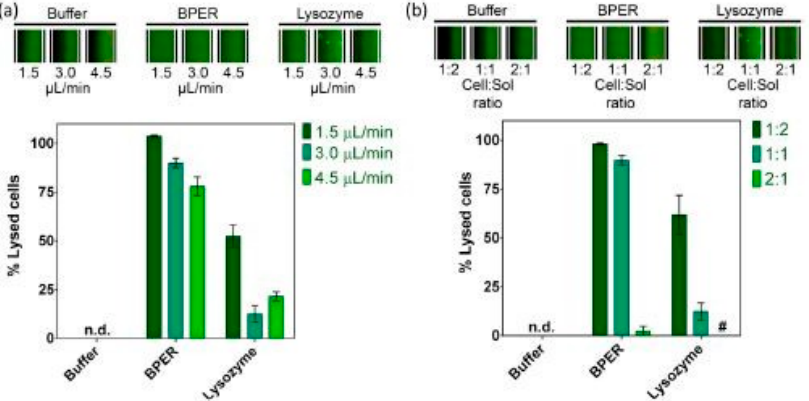
Figure 4. Percentage of cell lysis obtained in [18] for buffer resuspended cells, using Tris–HCl buffer, BPER, and lysozyme. ( a ) For different total flow rates (using the same flow rates of resuspended cell solution and buffer or lysis solution); ( b ) for different flow rate ratios (keeping constant total flow rate). Adapted with permission from [18]. Copyright 2020 Copyright Elsevier.